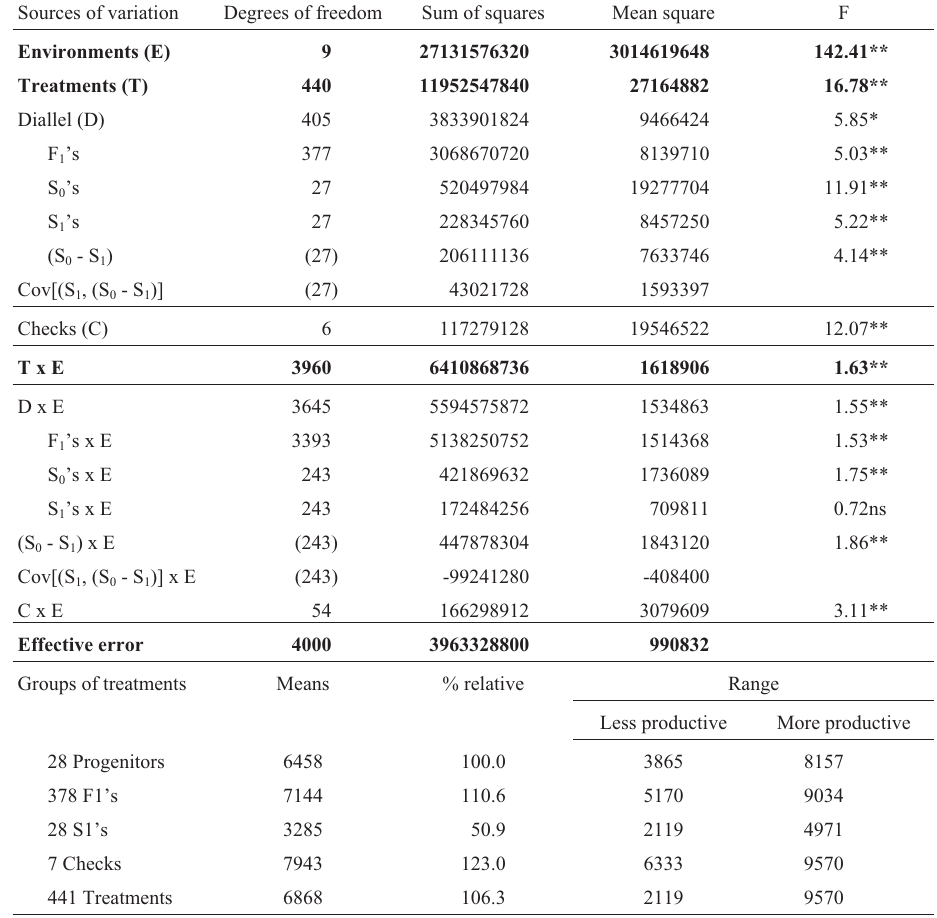
Table II - Combined analysis of variance for the 10 environments, with adjusted means of the 28 parents, their 378 inter varietal hybrids, 28 S1’s and seven checks. Ear weight (kg/ha) in 10 environments (1991/92 and 1992/93). Sources of variation Degrees of freedom Sum of squares Mean square F Environments